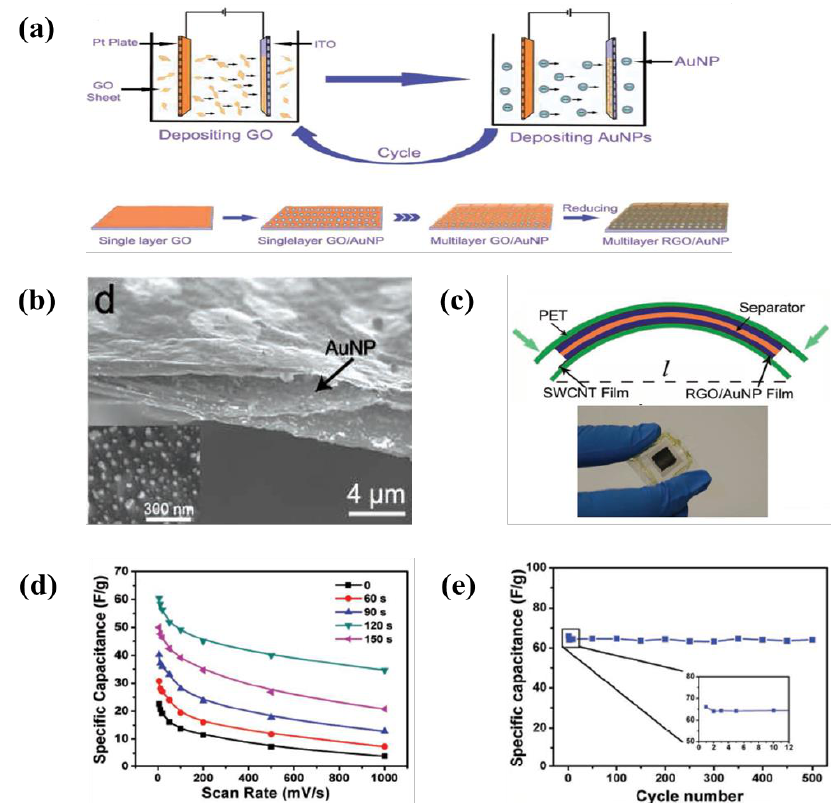
Figure 26. ( a ) Schematic diagram of the process for producing multilayered reduced graphene oxide/Au nanoparticles hybrid electrode; ( b ) Cross-section SEM image of multilayered reduced graphene oxide/Au nanoparticles hybrid electrode; ( c ) Schematic diagram of the optical image and multilayered reduced graphene oxide/Au nanoparticles hybrid electrode supercapacitor; ( d ) Specific capacitance of multilayered reduced graphene oxide/Au nanoparticles hybrid electrode supercapacitors with different Au nanoparticles deposition times at different scan rates; ( e ) Variation of the capacitance stability of the hybrid electrode supercapacitor with the number of cycles.